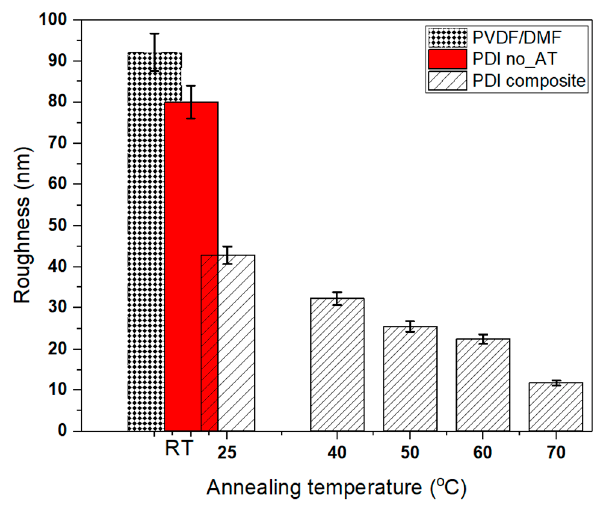
Figure 13. Surface roughness of PVDF samples in Figure 12.